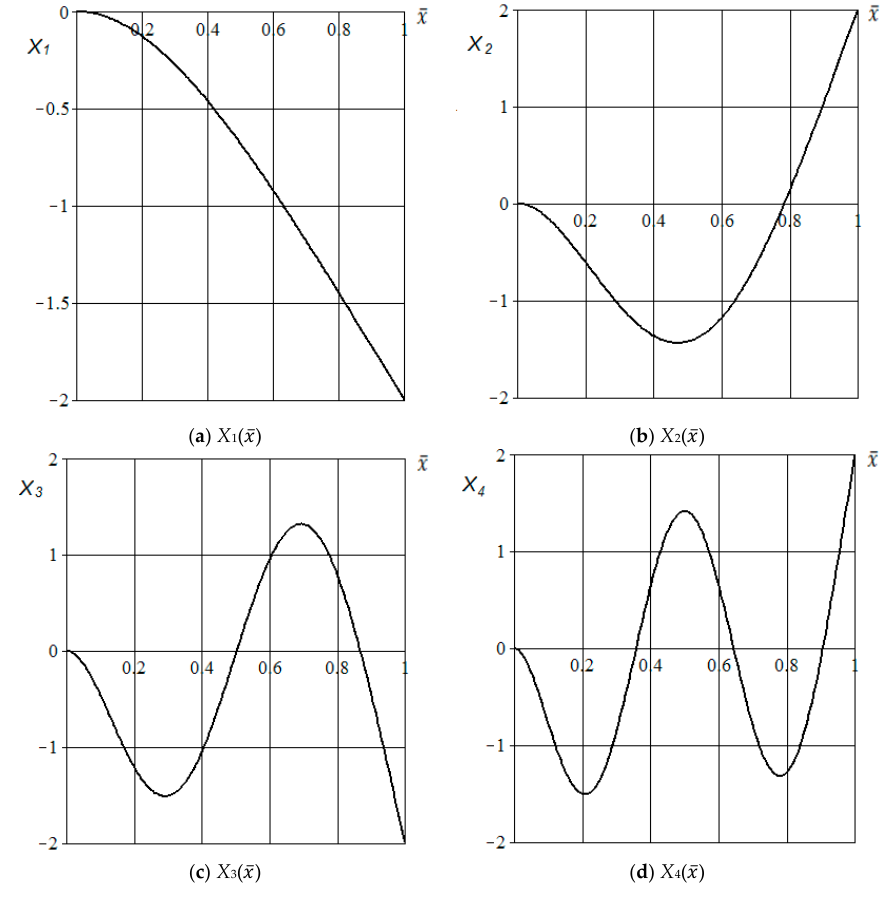
Figure 12. The basic functions X n ( x )